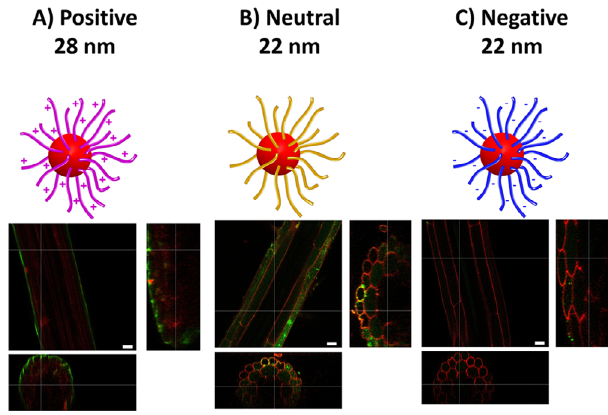
Fig. 3 | Root cross-sections illustrate nanoparticle accumulations. Cross- sections of roothair zonesafteruptakeofsmallnanoparticles with ( a )positive, ( b ) neutral, and ( c ) negative surface charges, respectively. Propidium iodide staining wasusedtooutlinethecellularstructure(red)whilethenanoparticlesareingreen, and areas of co-localisation appear yellow. ImageJ software was used to generate the orthogonal views from the Z-stack images. Scale bar=20 μ m. The images are representatives of experimental replicates ( n